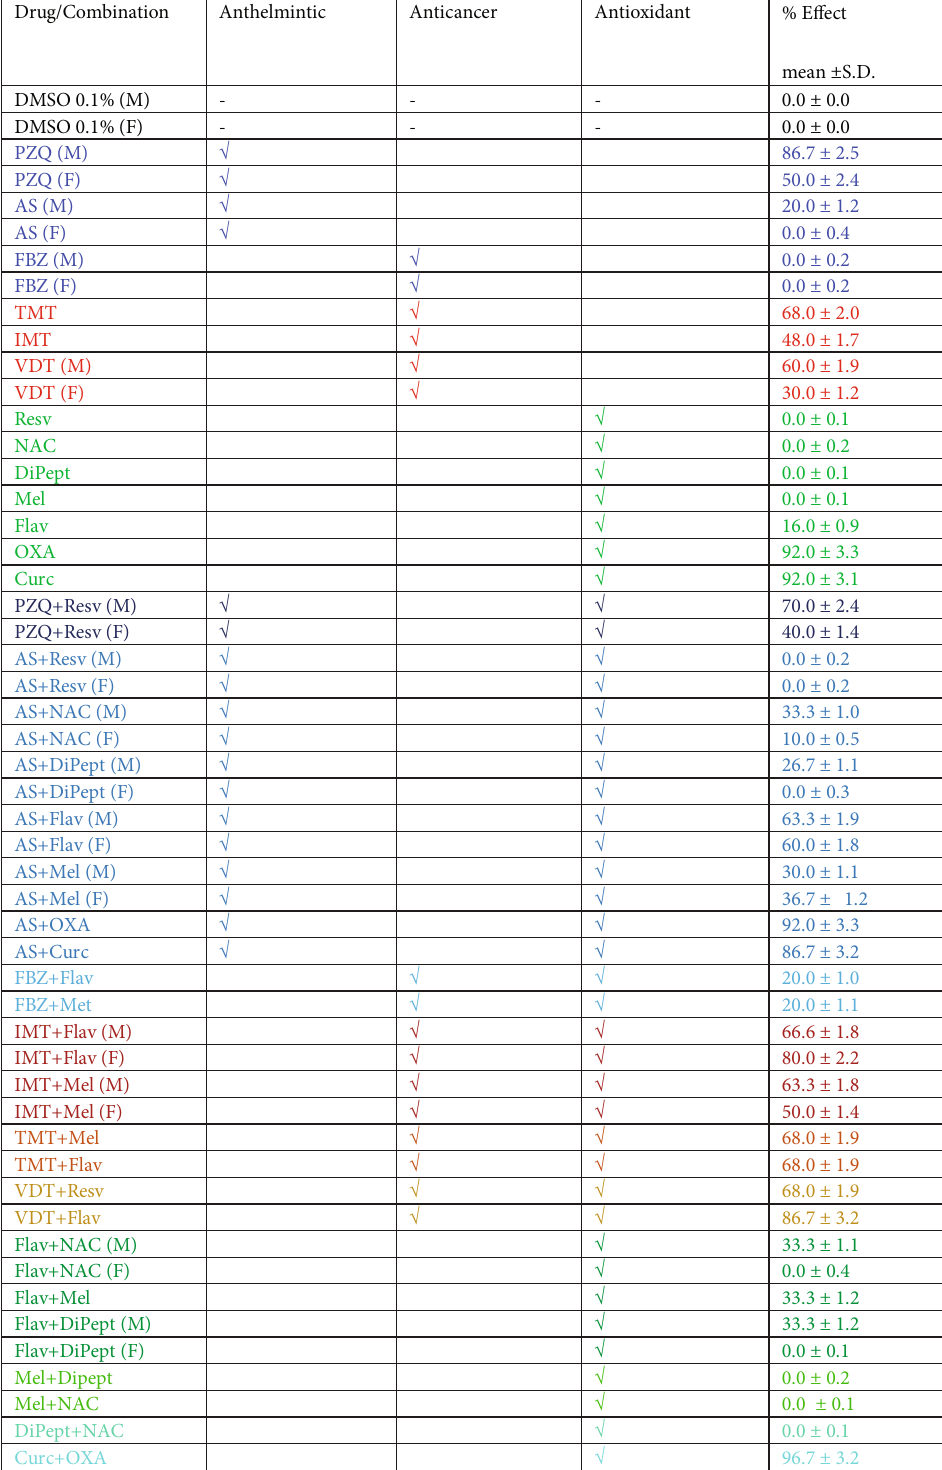
Figure 2: Score viability of the percentage of the e ff ect of drugs and antioxidants against adult worms of S. mansoni in vitro . M: males; F: